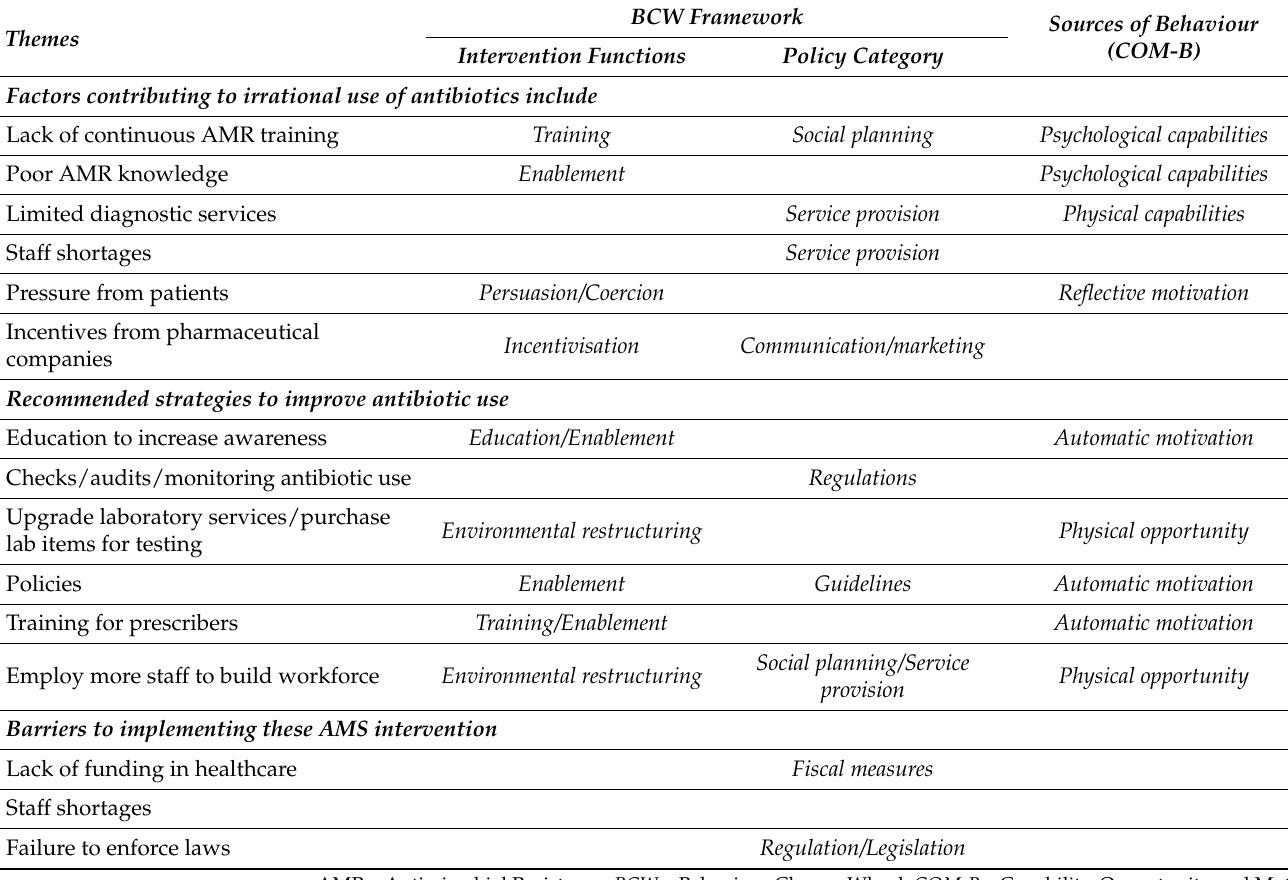
Table 5. Mapping codes and themes to the BCW and COM-B